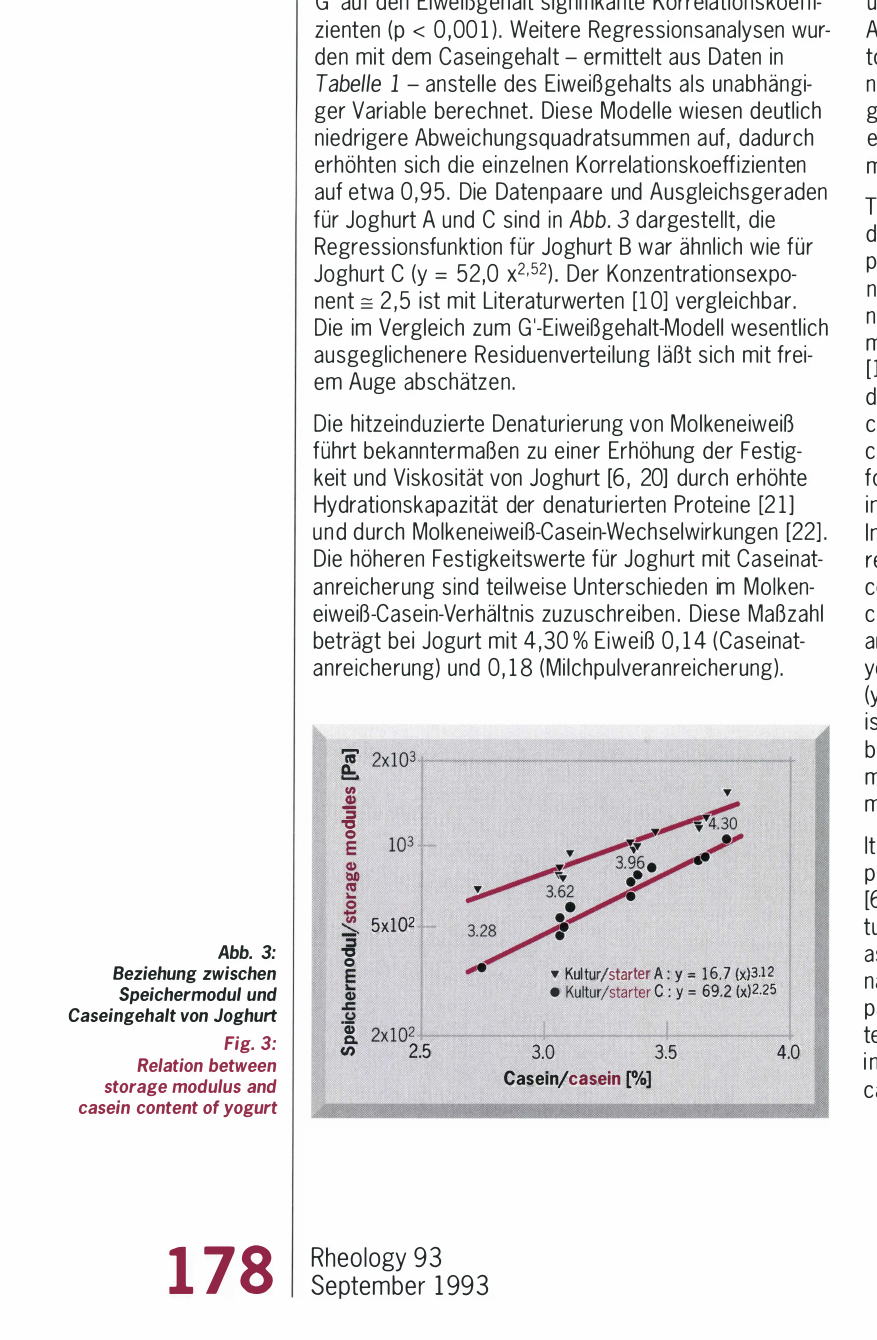
0,05). 0.05). ated and found to be independent of starter culture and fortification substrate (Table 4). As compared to tan o data of stirred yogurt(-0.35 in [19]) tan o val­ ues of intact yogurt gels were sufficiently